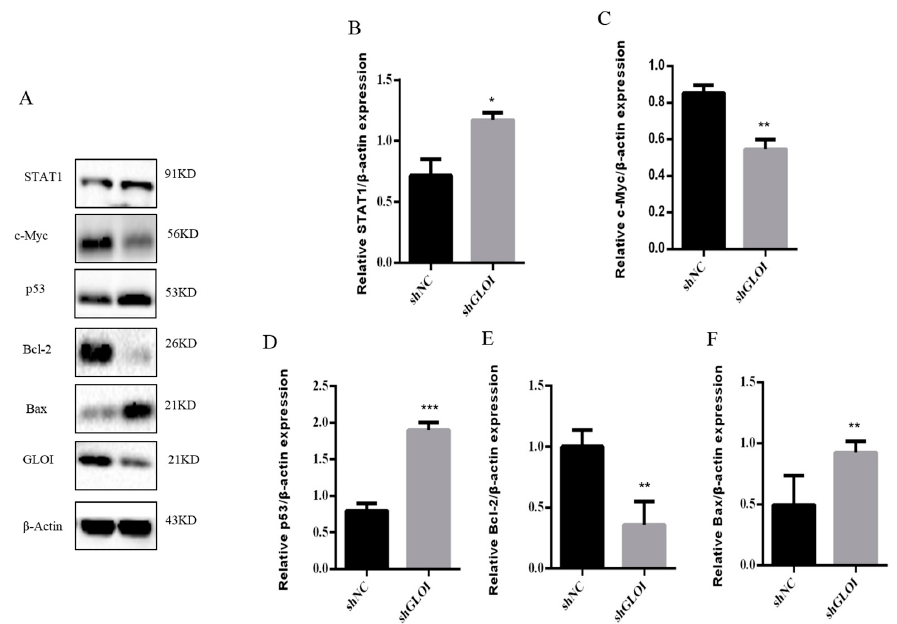
Figure 10. GLOI knockdown alters expression of STAT1 or p53 signal pathway proteins in SW620 colorectal tumors. Tumors were generated by injecting BALB/c nude mice with SW620 cells transfected with shGLOI or shNC (empty vector). ( A ) The expression of STAT1 or p53 signal pathway proteins and GLOI in the tumors were analyzed by western blot. ( B – F ) The expression of each protein was quantified and graphed for comparison. * p < 0.05, ** p < 0.01, *** p < 0.001. All data are representative of three independent experiments ( n = 3).